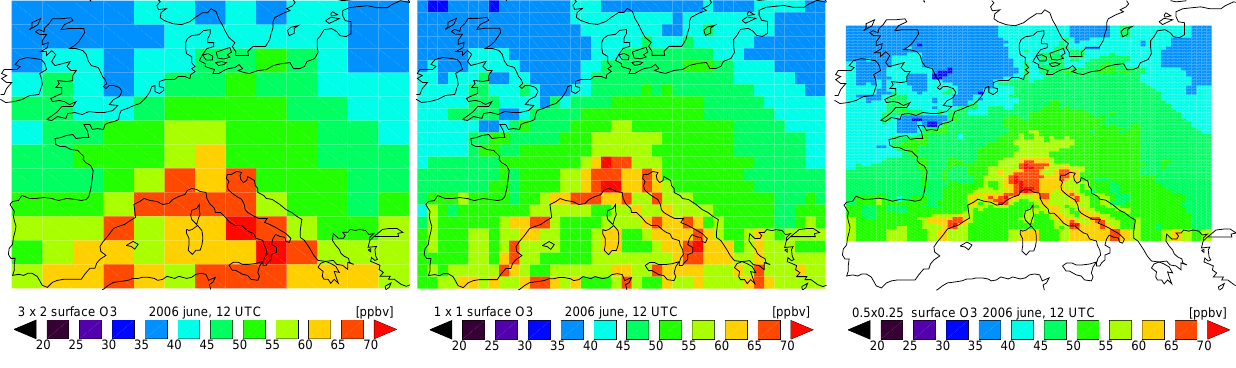
Fig. B1. Monthly mean surface ozone fields over Europe for June 2006 at 12:00UTC, as simulated with increasing levels of